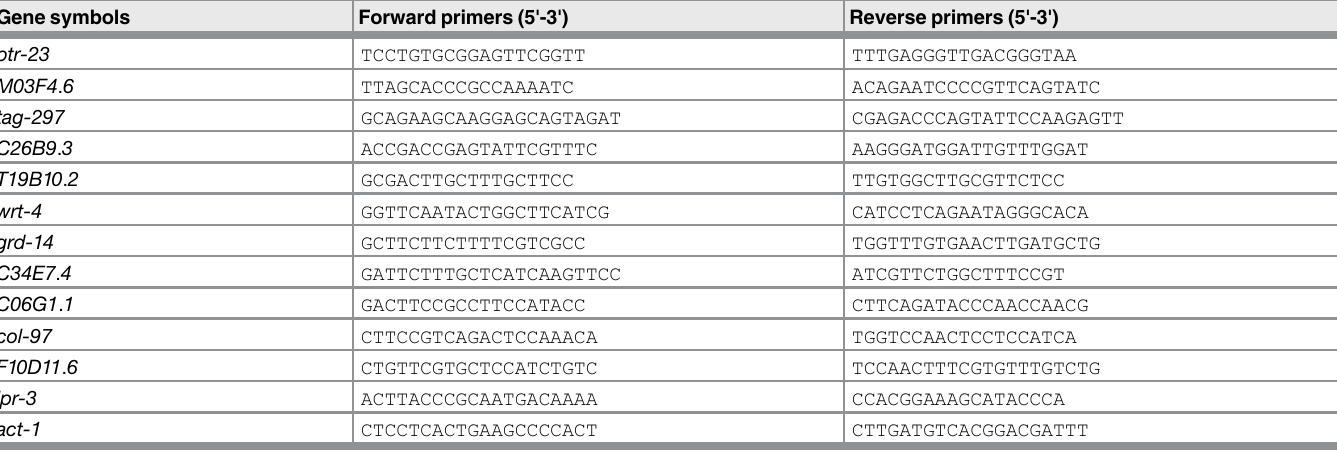
Table 2. The primers of selected genes for quantitative RT-PCR. Gene